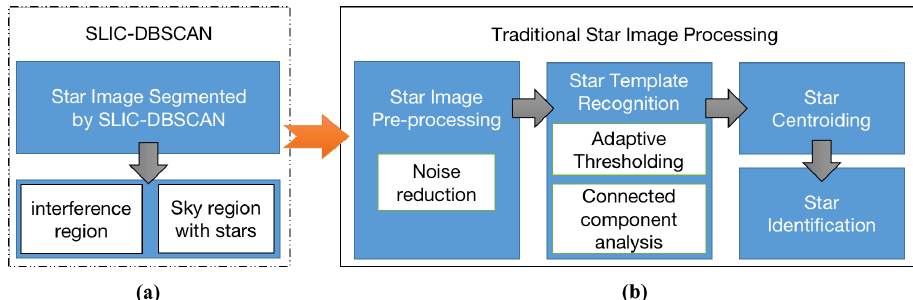
Figure 4. Proposed algorithm is the pre-processing for star images with large-area interference. They can be accomplished in two steps: ( a ) SLIC-DBSCAN is utilized to detect the region of large-area interference; ( b ) the other star spot extraction algorithm is implemented to segment stars, and the noise (such as single point noise, etc.) reduction technique is also